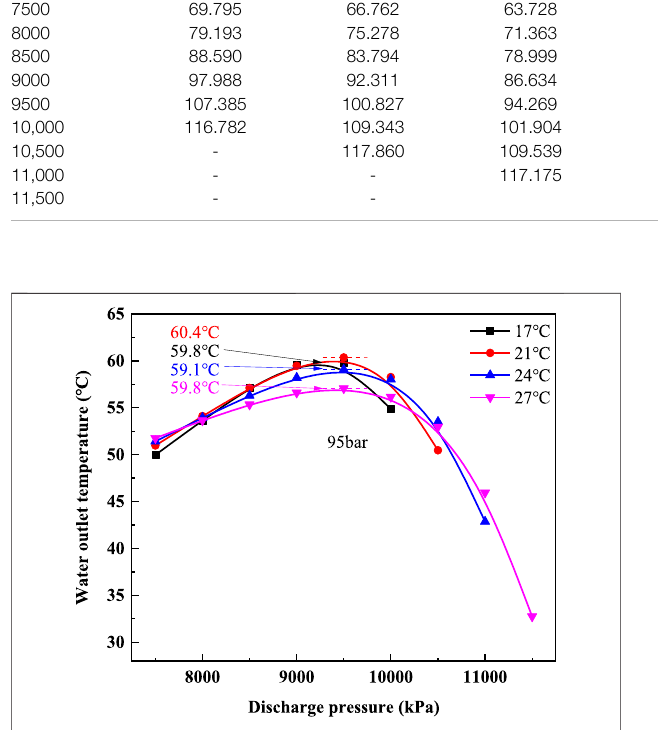
FIGURE 13 | Changes of GCW with discharge pressure at different ambient temperatures and the compressor frequency of 20